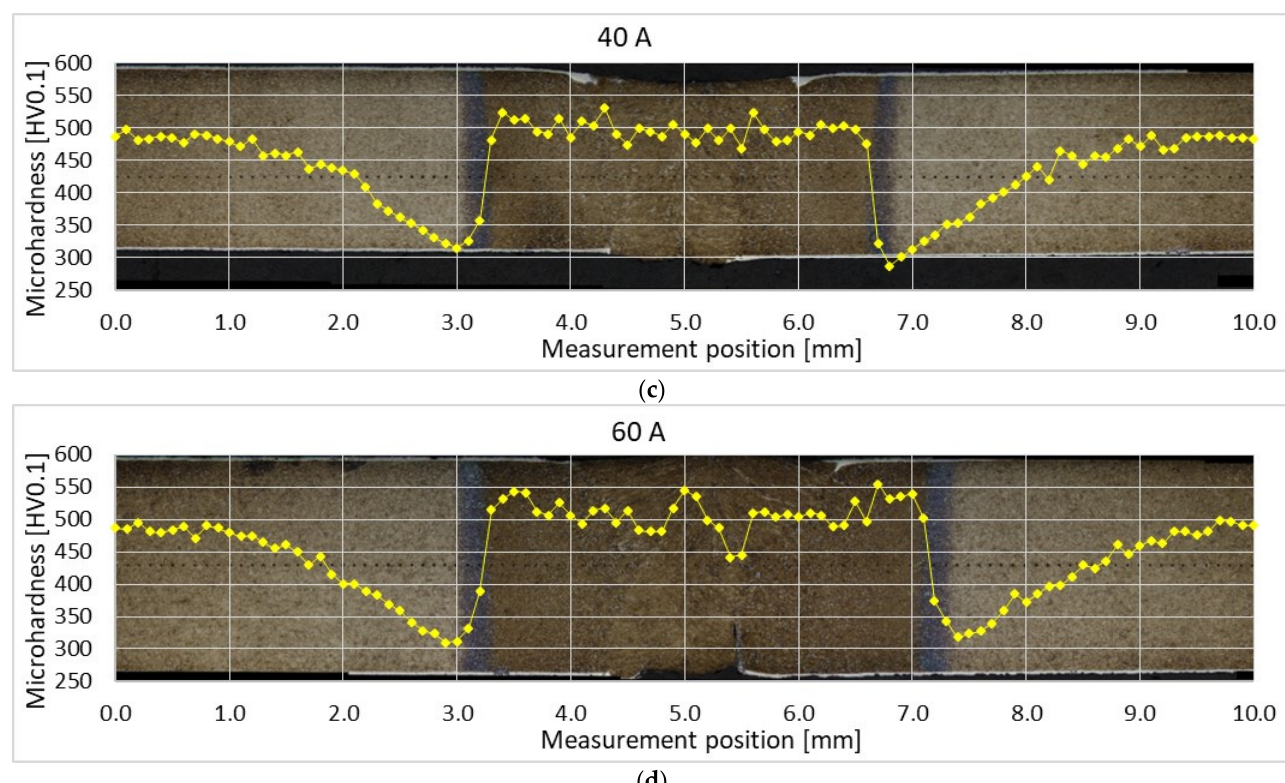
Figure 11. Microhardness of ( a ) laser weld and hybrid welds made with ( b ) 20 A, ( c ) 40 A, and ( d ) 60 A.